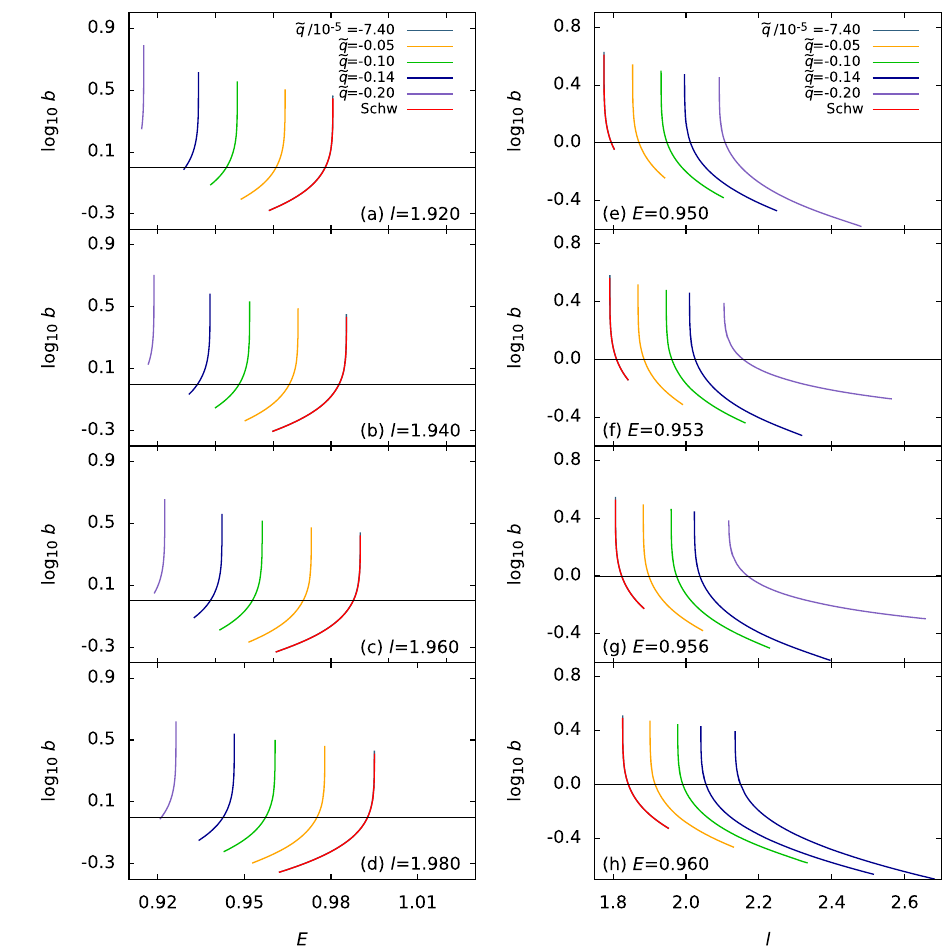
Fig. 7 As the parameter ˜ q takes different values, b varies with E for fixed l (left column) and varies with l for fixed E (right